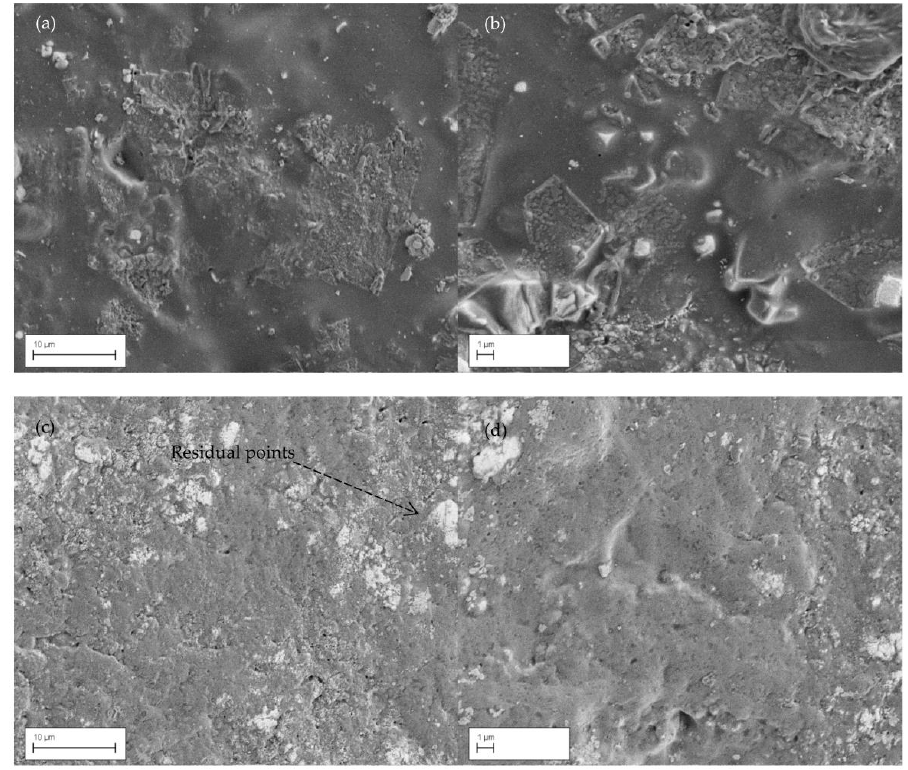
Figure 2. Scanning electron micrographs (SEMs) showing: ( a ) and ( b ) SEM of dry electrode before coating; ( c ) and ( d ) graphene-coated dry electrode.